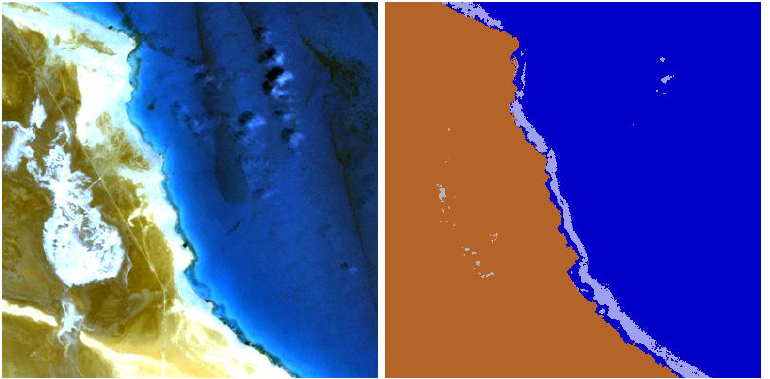
Figure 7 . Bright coastal water with spectrum similar to ‘cloud over